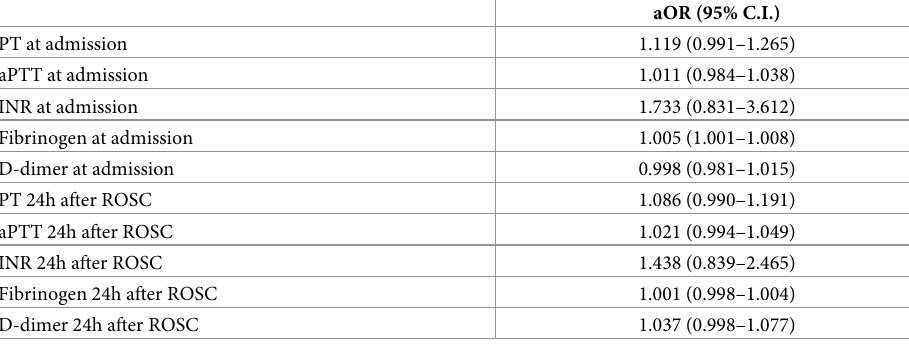
Table 3. Adjusted odds ratios of coagulation-related factors for in-hospital